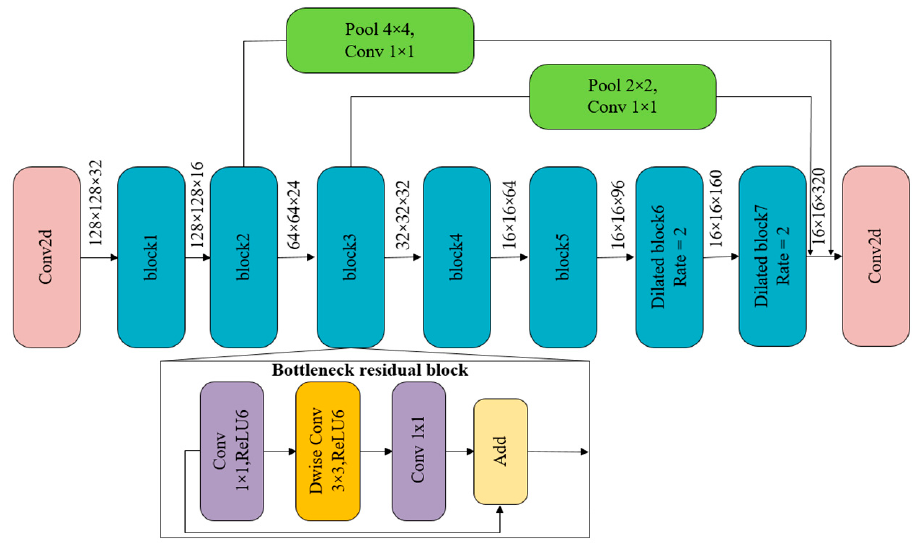
Figure 4. Structure diagram of the feature extraction module.